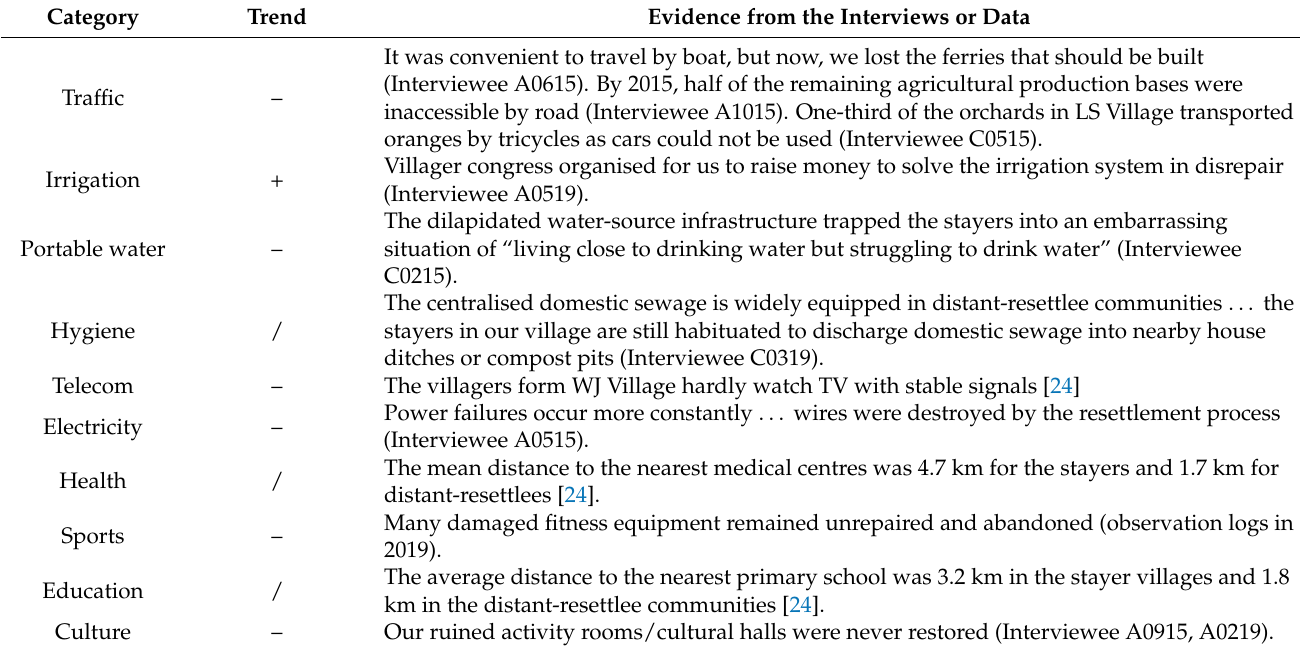
Table 5. Changes to infrastructures and services in the stayer